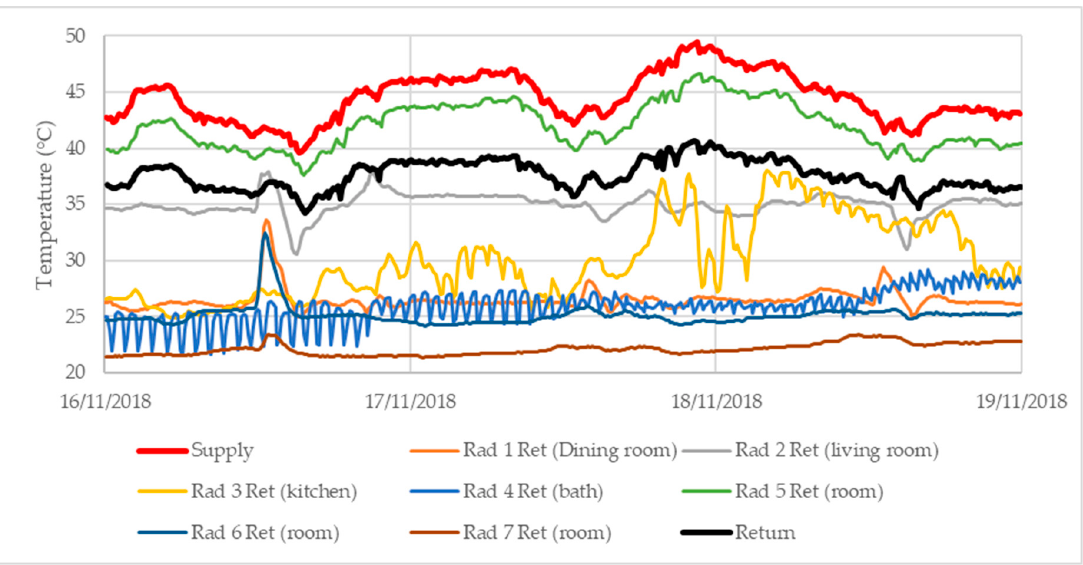
Figure 15. Recording of the radiator system supply and return temperatures and the return temperature from all the radiators (Rad) of a specific apartment, located on the first floor at the west end of the building, during the period between 16 November 2018 and 19 November 2018, before the implementation of the two suggested